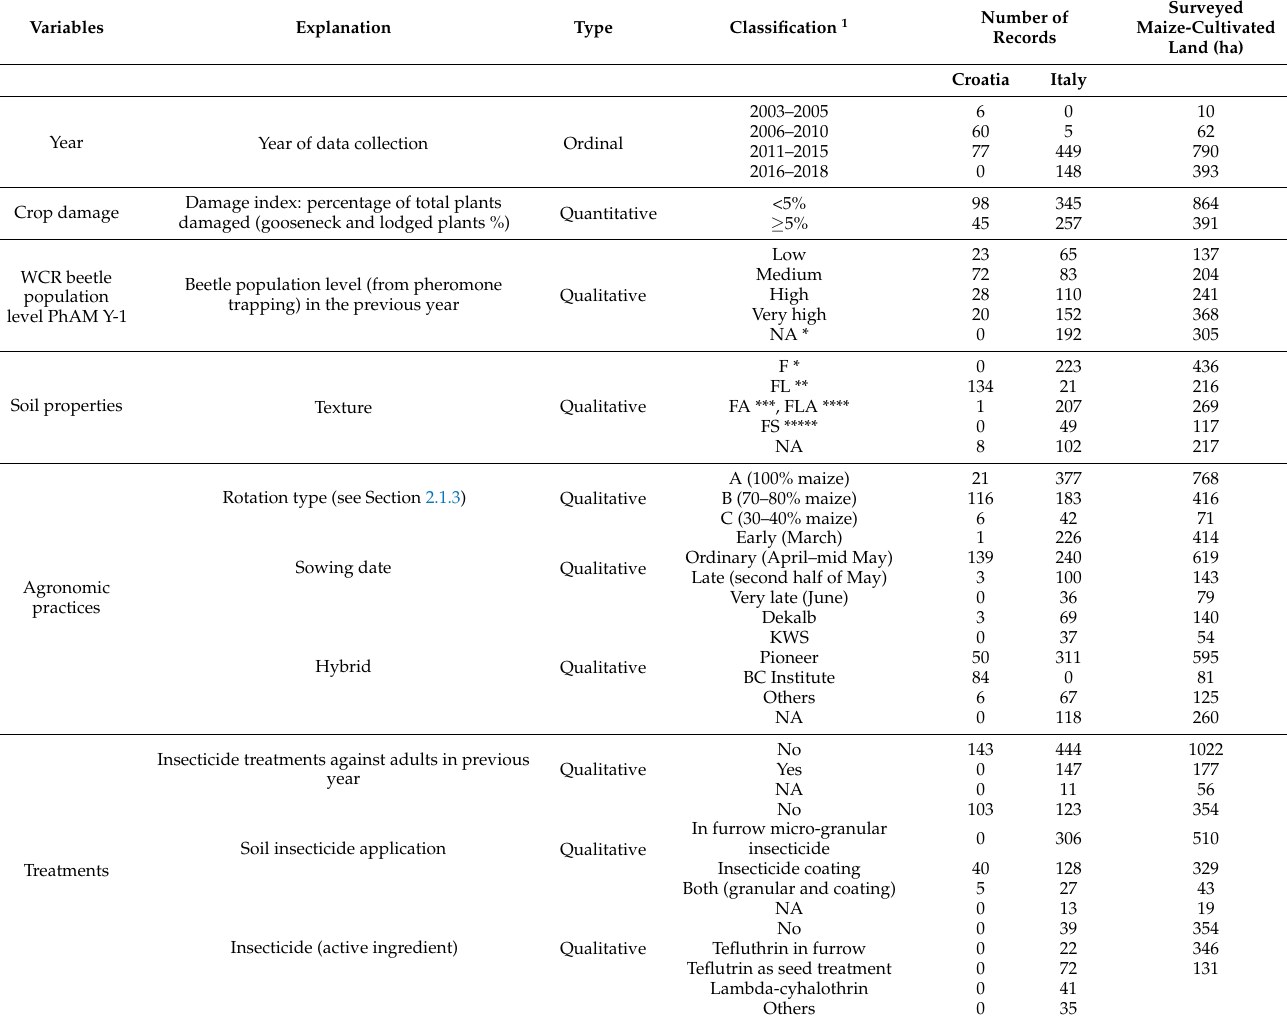
Table 1. List of the variables included in the